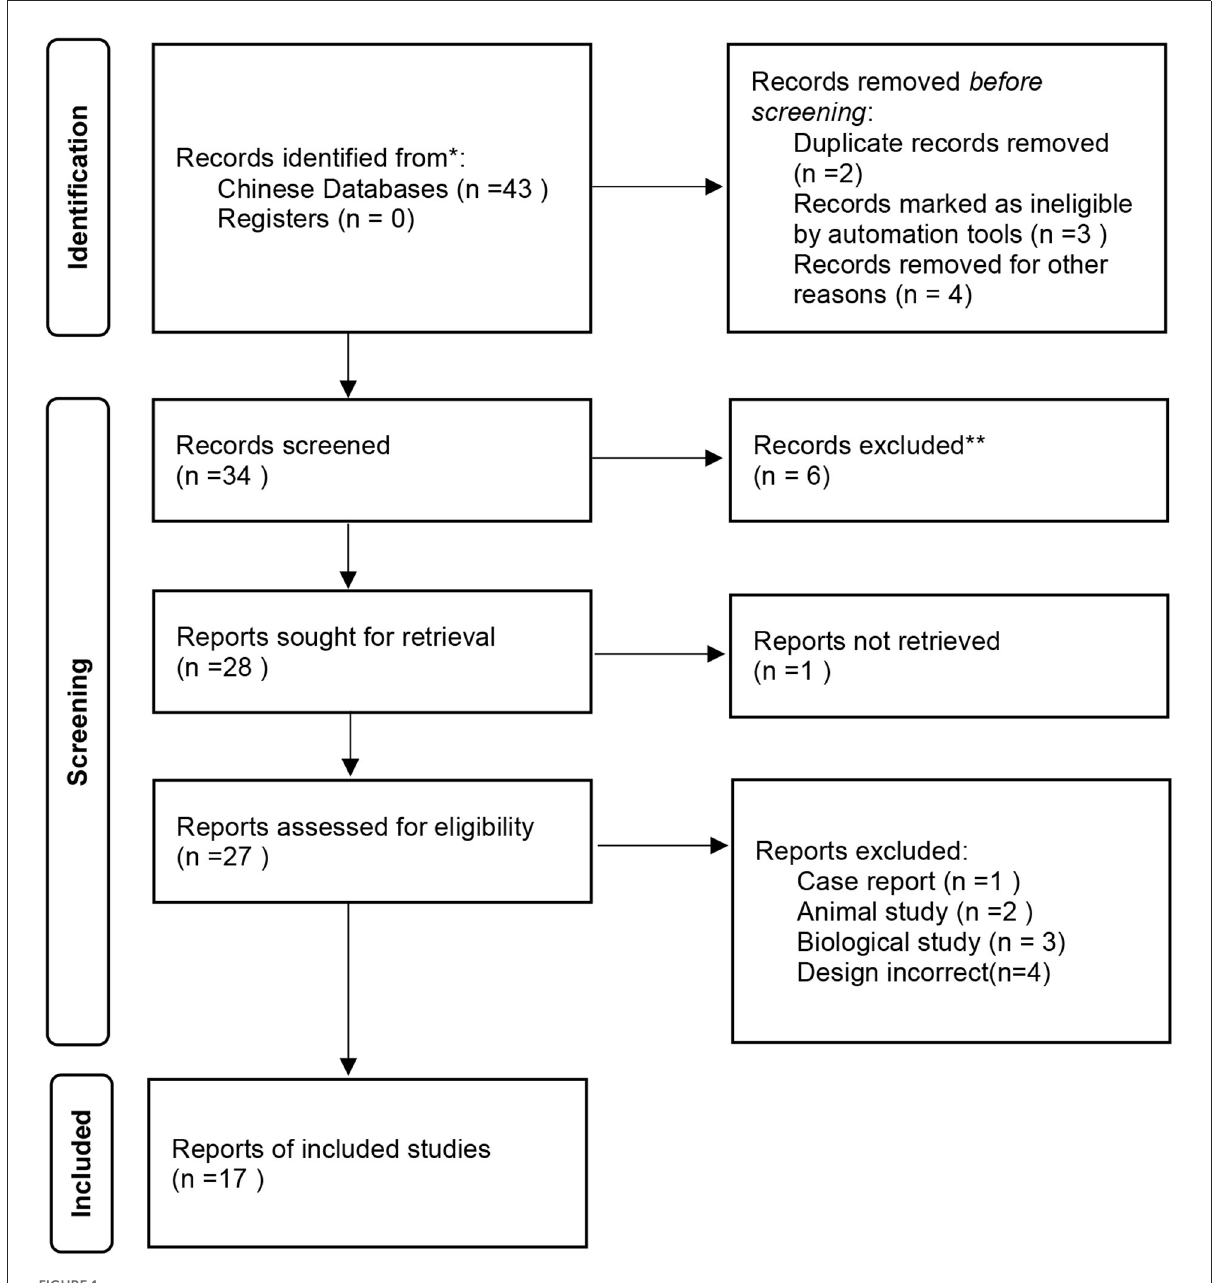
FIGURE1 Identification, assessment and retrieval of studies.